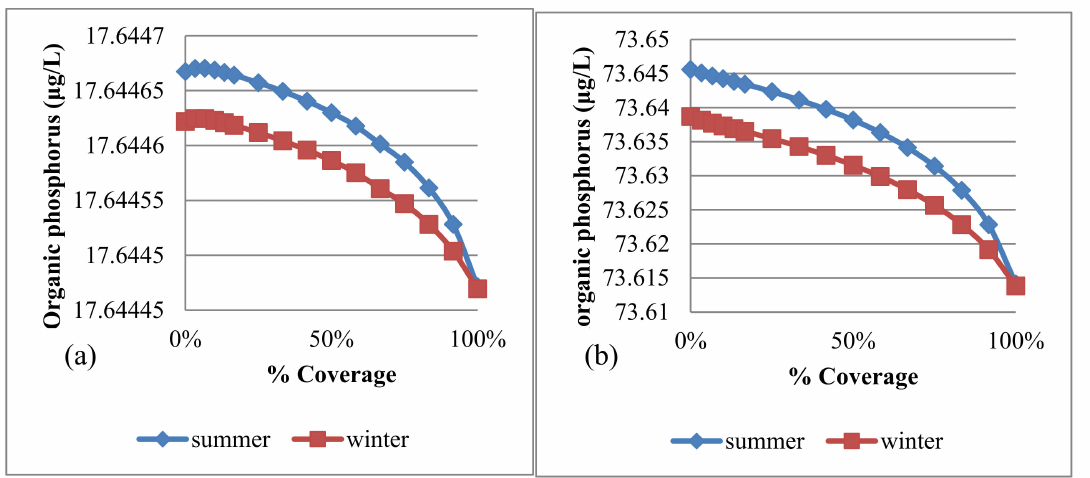
Figure 11. ( a ) The organic phosphorus concentration at the canal end in the winter and summer vs. percentage coverage for the 50-km length of the Canal, ( b ) the inorganic phosphorus concentration at the canal end in the winter and summer vs. percentage coverage for the 50-km length of the